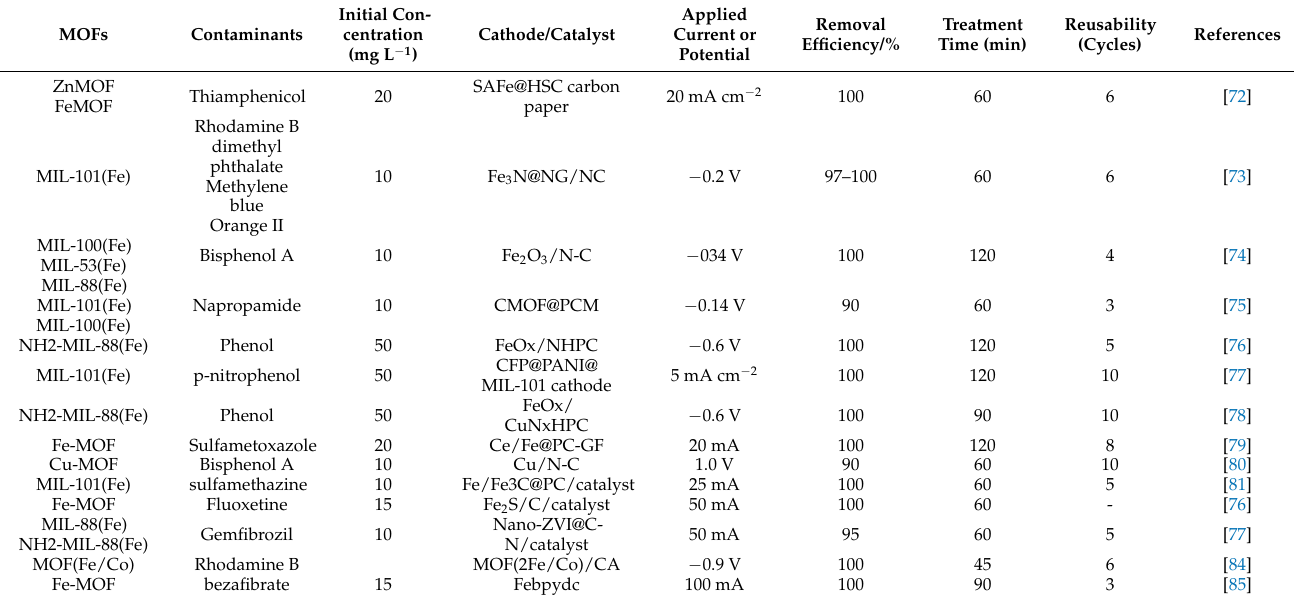
Table 1. Comparison of heterogeneous EF and PEF performance using MOF-based materials for the treatments of several organic pollutants in different aqueous